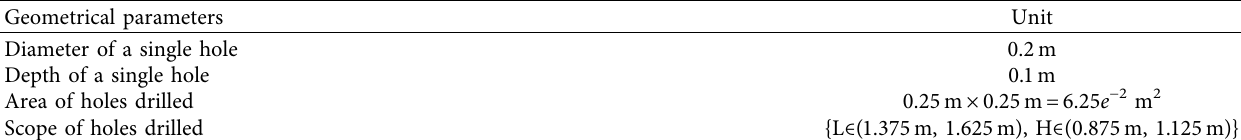
Table 4: The parameters of the holes.